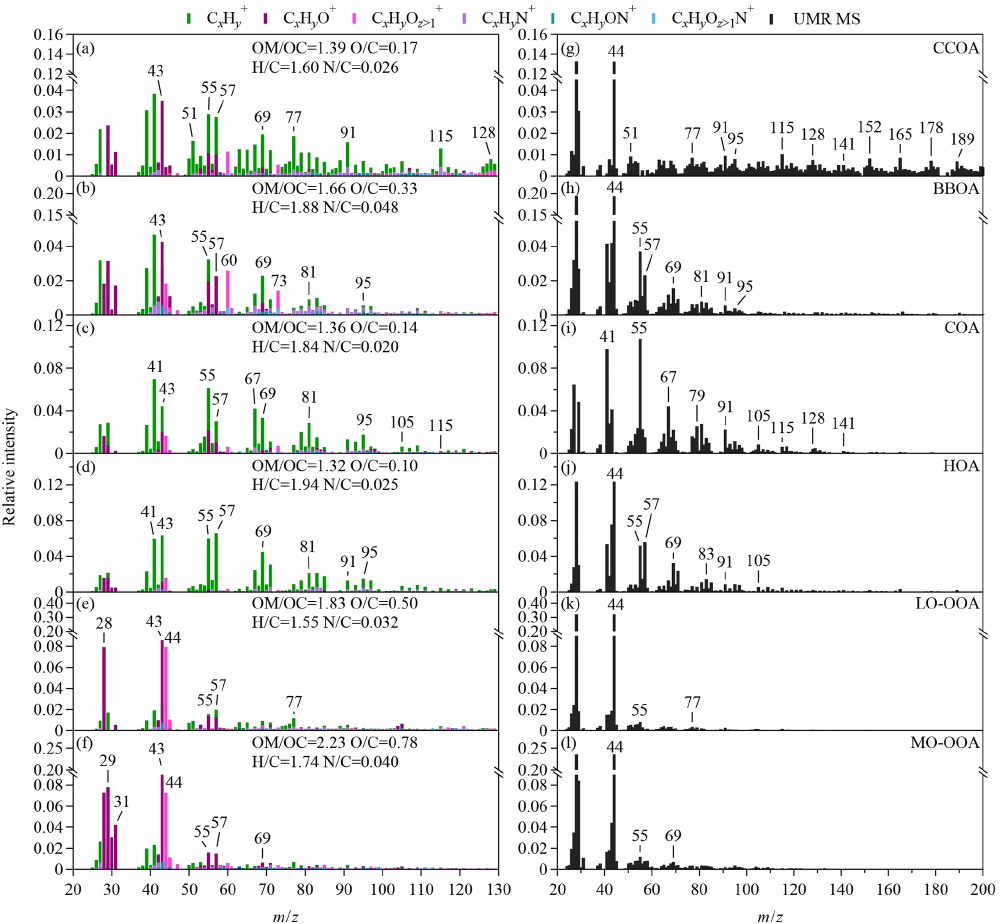
Figure 4. Mass spectra of the statistical OA factors, CCOA, BBOA, COA, HOA, LO-OOA, and MO-OOA that are identified by the PMF analysis. The high-resolution intensity bars in panels (a) – (f) are color-coded by the contribution of various ion families (i.e., fragments containing C, H, O, or N for subscripts of x , y , and z ), as determined from the analysis of the SV AMS data. The elemental ratios of atomic hydrogen-to-carbon (H / C), oxygen-to-carbon (O / C), and nitrogen-to-carbon (N / C) ratios and the organic-mass-to-organic-carbon ratios (OM / OC) of each factor are calculated from the SV AMS data on the basis of the “Improved-Ambient” method (Canagaratna et al., 2015). The UMR bars in panels (g) – (l) are calculated from the CV TOF-ACSM data. The m/z range of 12 to 20 was included in the PMF analysis although not